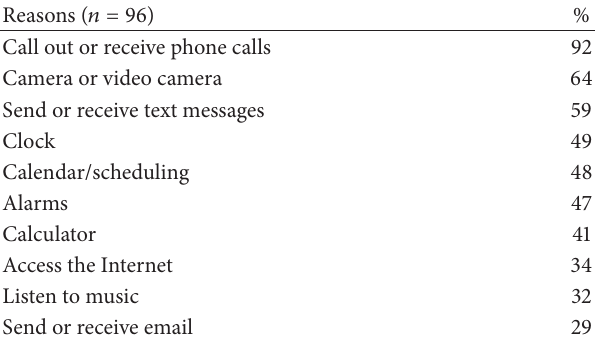
Table 2: Reasons given for using their cell